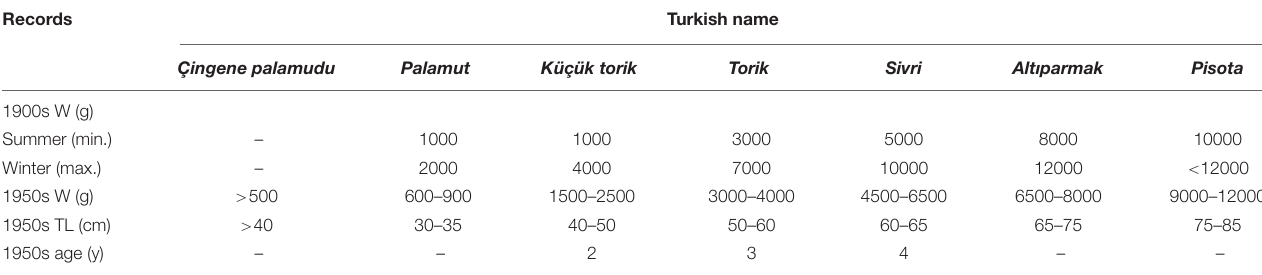
TABLE 6 | Fished different size classes and age for bonito ( Sarda sarda ) in the early 1900s and